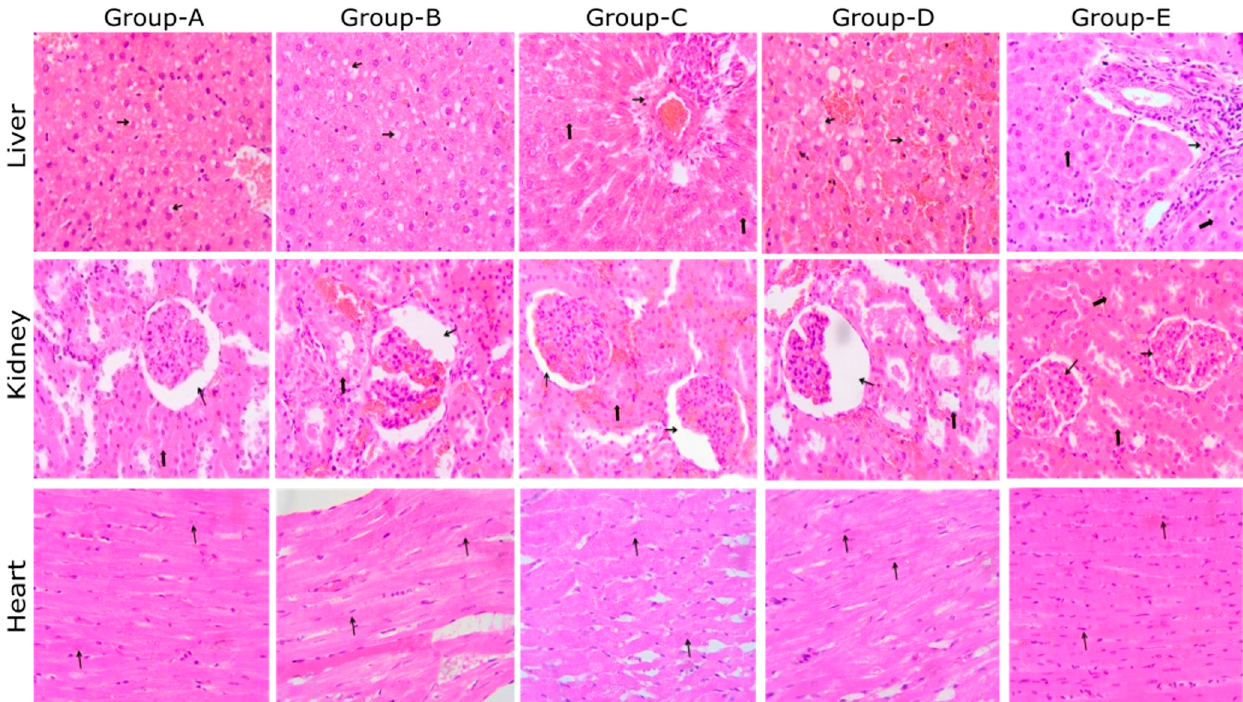
Figure 3. Histopathological analysis of rat liver, kidney, and heart. Liver: showing cytoplasmic vacuolation of hepatocytes (thin arrow); Groups A, B, and D; showing normal histology, portal triad (thin arrow), and hepatocyte (thick arrow); Groups C and E (H & E, 400×). Kidney: showing dilated bowman’s space (thin arrow); note the normal tubule (thick ar- row); Groups A, B, C, and D; showing normal histology, glomeruli (thin arrow), and tu- bules (thick arrow); E (H & E, 400×). Heart: showing normal histology, muscle fiber (thin arrow); A, B, C, D, and E (H & E, 400×).